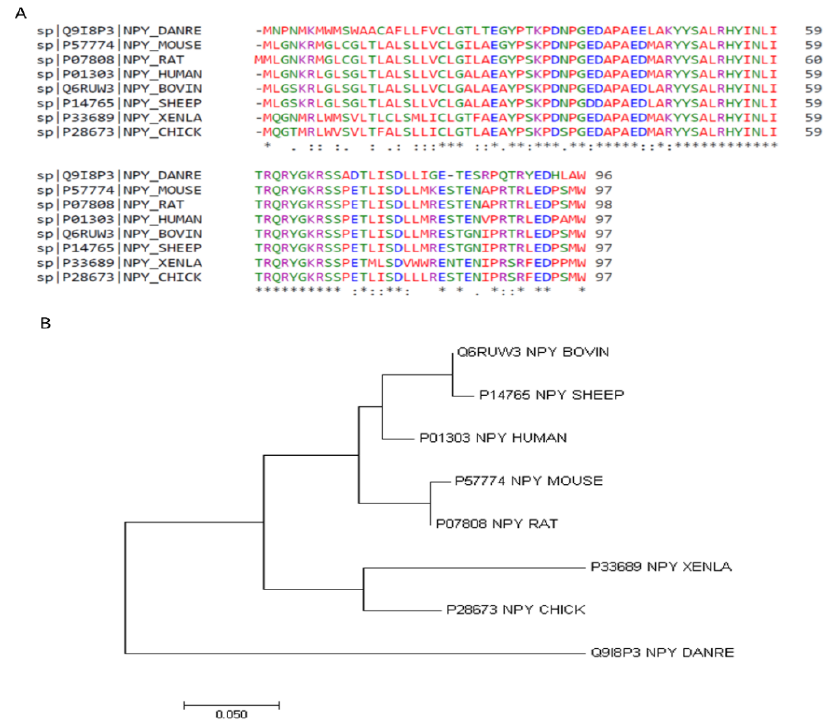
Figure 1. NPY amino acid sequence alignments ( A ) and phylogeny ( B ). Amino acid sequences were aligned using Clustal Omega 1.2.4 [32]. * positions with a single, fully conserved residue. “:” (colon) conservation between groups of strongly similar properties. “.” (period) conservation between groups of weakly similar properties. Phylogenetic tree generated with MEGA7: Molecular Evolutionary Genetics Analysis version 7.0 for bigger datasets [33].